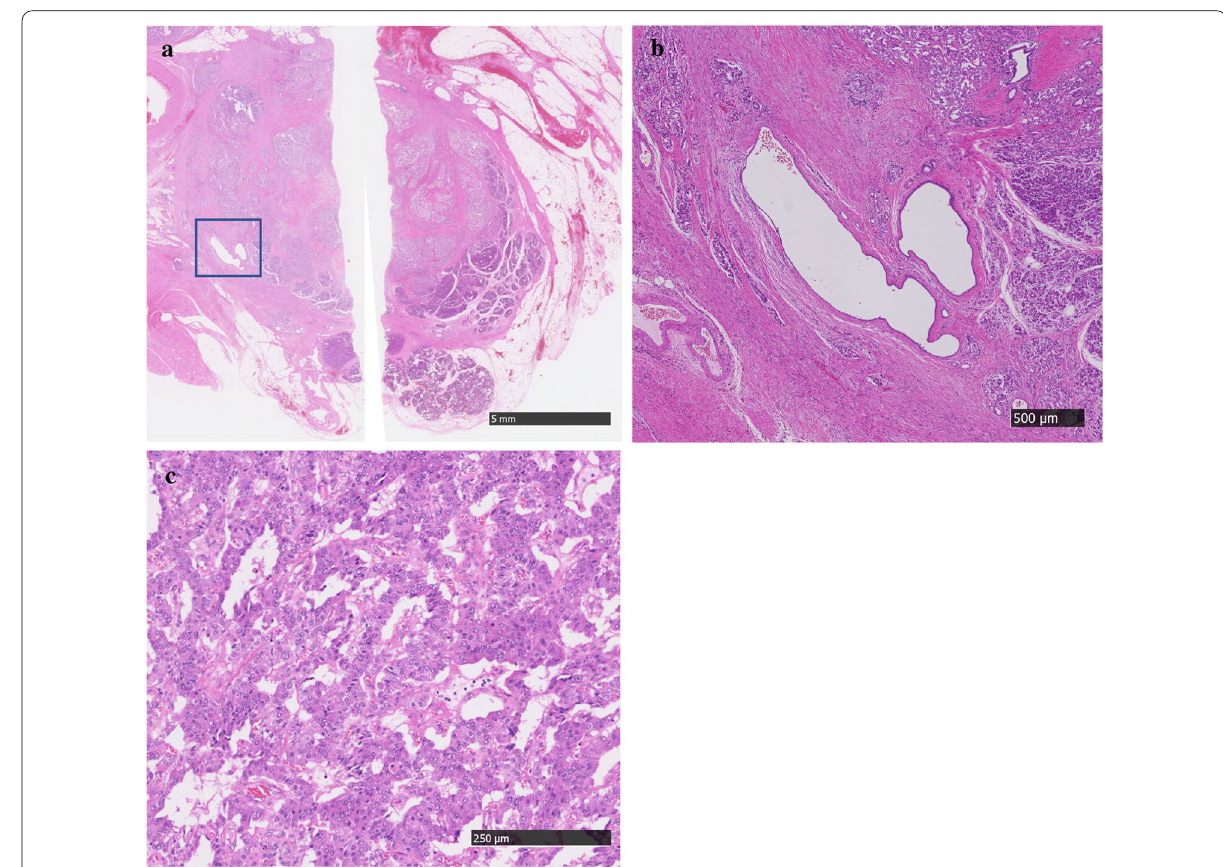
Fig. 5 Findings of histopathological analysis. The tumor appears as a solid neoplastic lesion covered with a fibrotic capsule, and it measures 19 17 14 mm. Hematoxylin and eosin (HE) staining shows fibrosis. a HE, low-power microscopic view. The main pancreatic duct (square) is × × compressed by the tumor and narrowed. b HE, high-power microscopic view. In the tumor, eosinophilic cells show a ribbon-like arrangement. c Each cell shows swollen nuclei, anisonucleosis, and atypia. There were 9 mitoses observed in 10 high-power fields